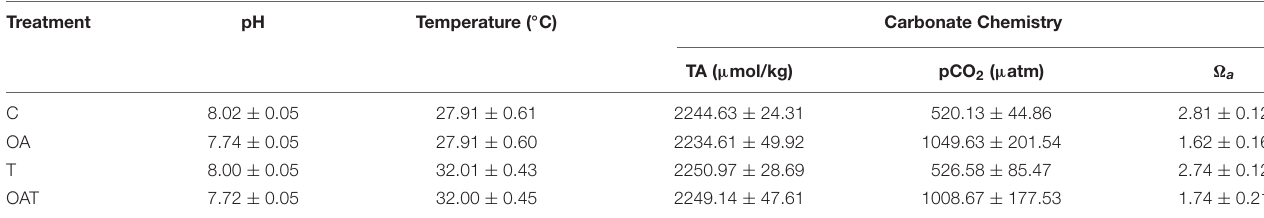
TABLE 1 | Physico-chemical values (mean ± SD) of pH-temperature treatments for 28 days; pH ( n = 255), temperature ( n = 8064), partial pressure of carbon dioxide (pCO 2 ; n = 15), aragonite saturation levels ( (cid:127) a ; n =